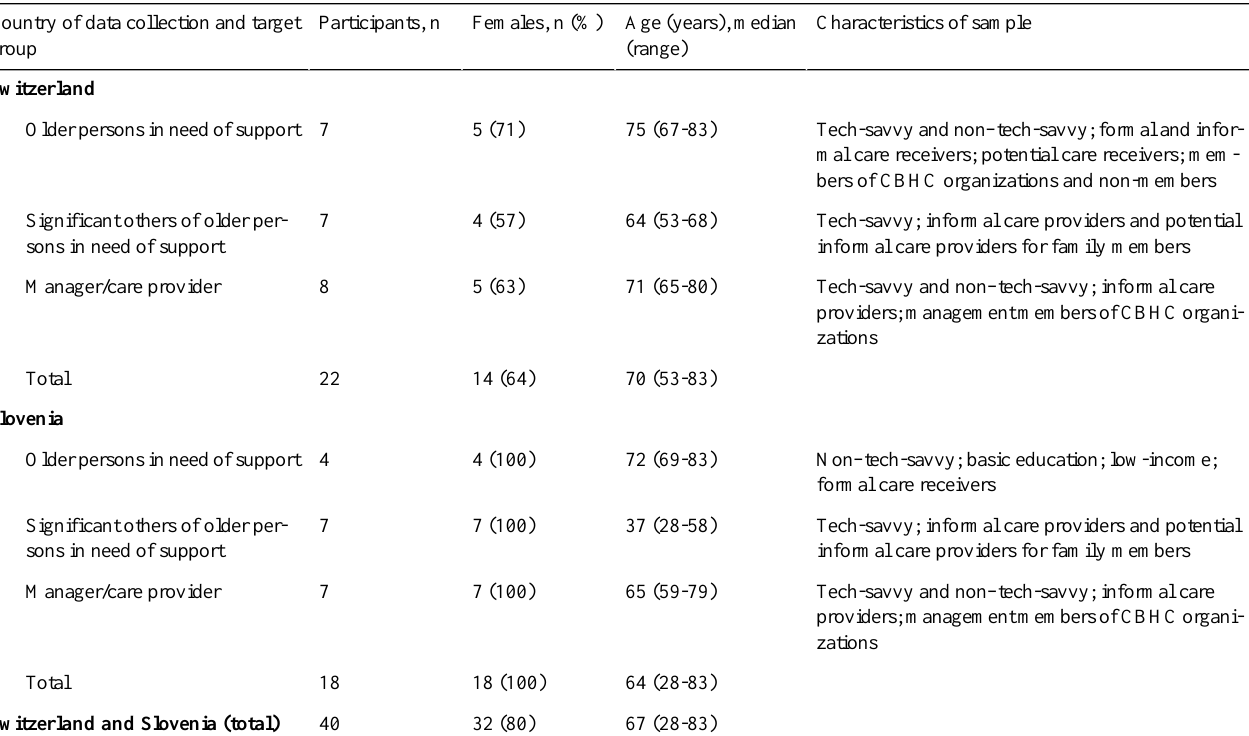
Table 2. Sociodemographic data from the three target groups in the focus